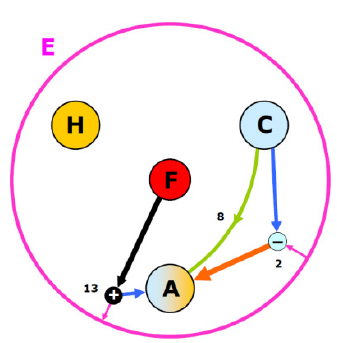
Fig. 11. – Hybrid system: free and active